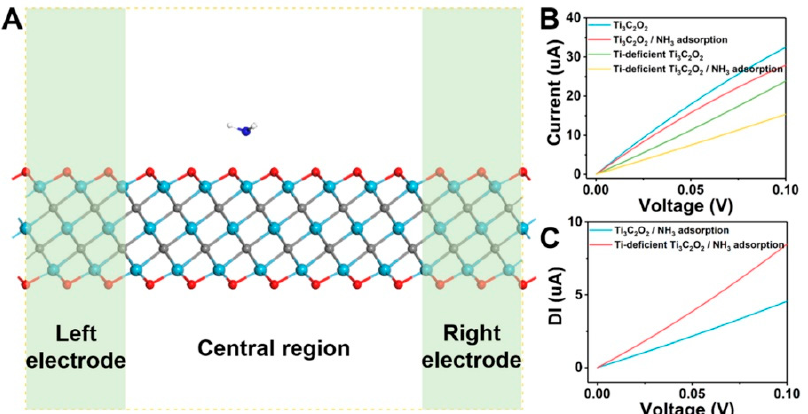
Figure 2. ( A ) Atomic-scale device simulation; ( B ) electronic transport behavior (I–V) of Ti 3 C 2 O 2 MXene and Ti-deficient Ti 3 C 2 O 2 MXene after NH 3 adsorption under series bias voltages; and ( C ) change in current after NH 3 adsorption. The left and right electrode regions of the two-probe system are in contact with the central region (4 × 4 supercell) to detect NH 3 molecules. Reprinted with permission from [81]. Copyright 2022: American Chemical Society.